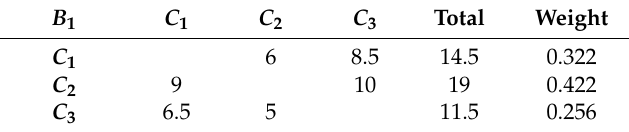
Table A2. Judgment matrix of C 1 – C 3 .